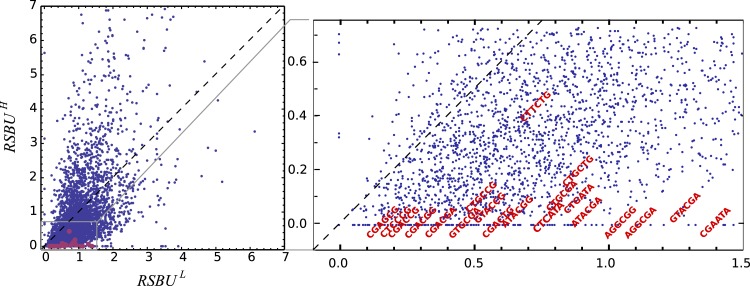
Bicodon preference in S. cerevisiae.The scatter plot of RSBUL
vs. RSBUH illustrates the preference of bicodons in yeast. The inhibitor bicodons reported by Gamble et al. (2016) are indicated in red.